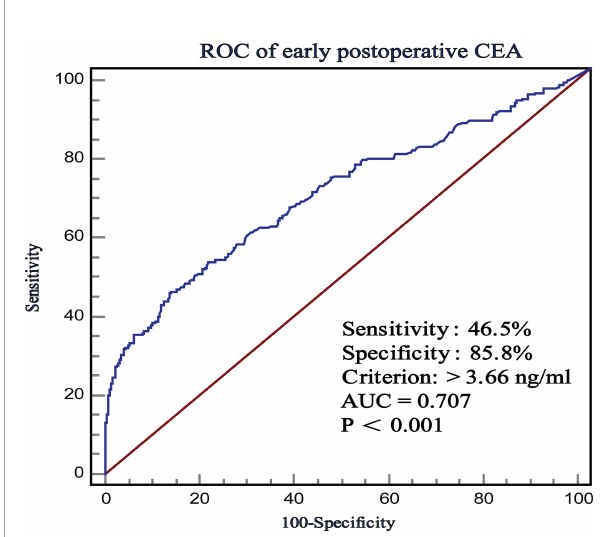
FIGURE 2 | The receiver operating characteristics (ROC) curves of postoperative CEA with respect to CSS.